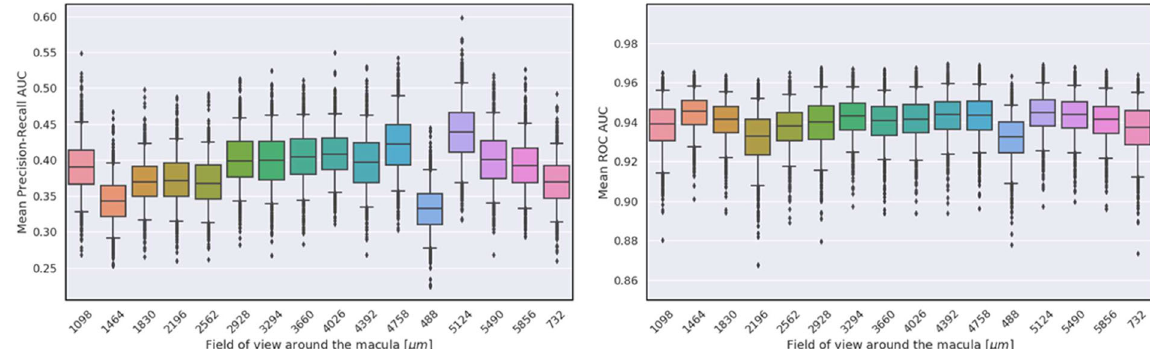
Fig. 8 The effect of the fi eld of view around the macula on SLIVER-net ’ s performance. Top: Mean precision-recall AUC across all biomarkers. Bottom: Mean ROC AUC across all biomarkers. Error bars represent 95% con fi dence interval (CI) calculated using a bootstrapping procedure.